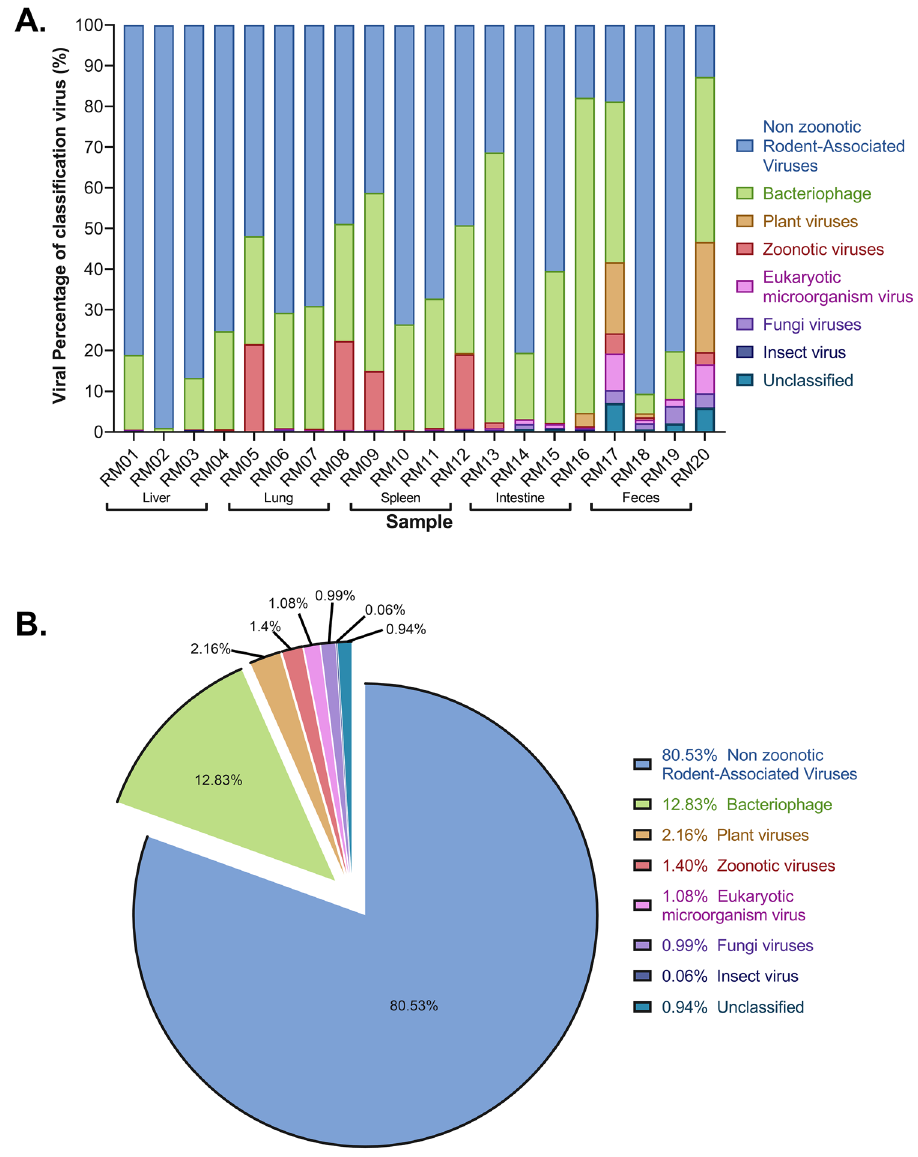
Figure 2. Proportion of viral sequence reads with BLASTX hits to the specified virus families. ( A ) Proportion in each library. The y-axis is the percentage of viral reads distribute to each classification, or that were unclassified viruses. The sample ID is shown on the x-axis. The percentage of reads was determined based on the raw number of viral-related reads. ( B ) Proportion in total viral